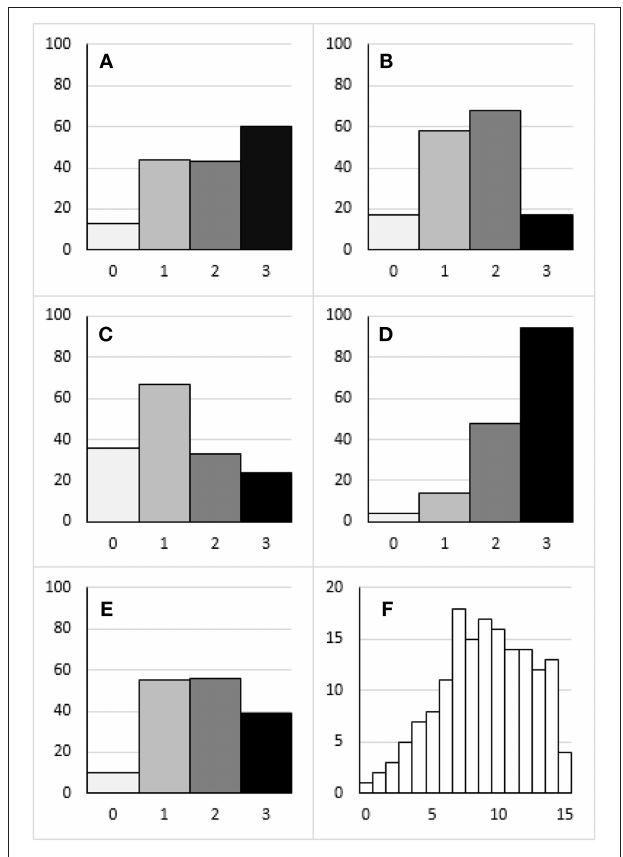
FIGURE 2 | Distributions of ratings for (A) Introduction and Description, (B) Scores and Performance Levels, (C) Supporting Material, (D) Language, (E) Design, and (F) Total